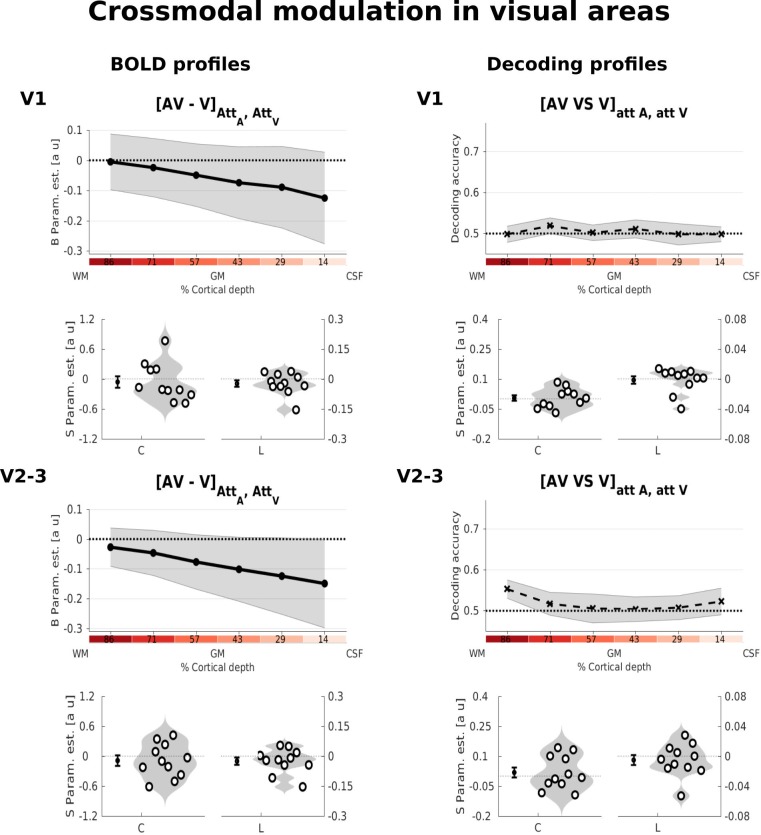
Cross-modal modulation in visual areas.Laminar profiles: Rows 1 and 3: The BOLD response (solid line; column 1 and 3) and decoding accuracy (dashed line; columns 2 and 4) (across subjects’ mean ± SEM) for [AV-A] in V1 and V2/3 is shown as a function of percentage cortical depth pooled (i.e. averaged) over auditory and visual attention. WM: white matter, GM: grey matter, CSF: cerebrospinal fluid. Percentage cortical depth is indicated by the small numbers and colour coded in red. Rows 2 and 4: Across subjects’ mean (± SEM) and violin plot of participants’ shape parameter estimates that characterize the mean (C: constant) and linear increase (L: linear) of the laminar BOLD response and decoding accuracy profiles. n = 11.